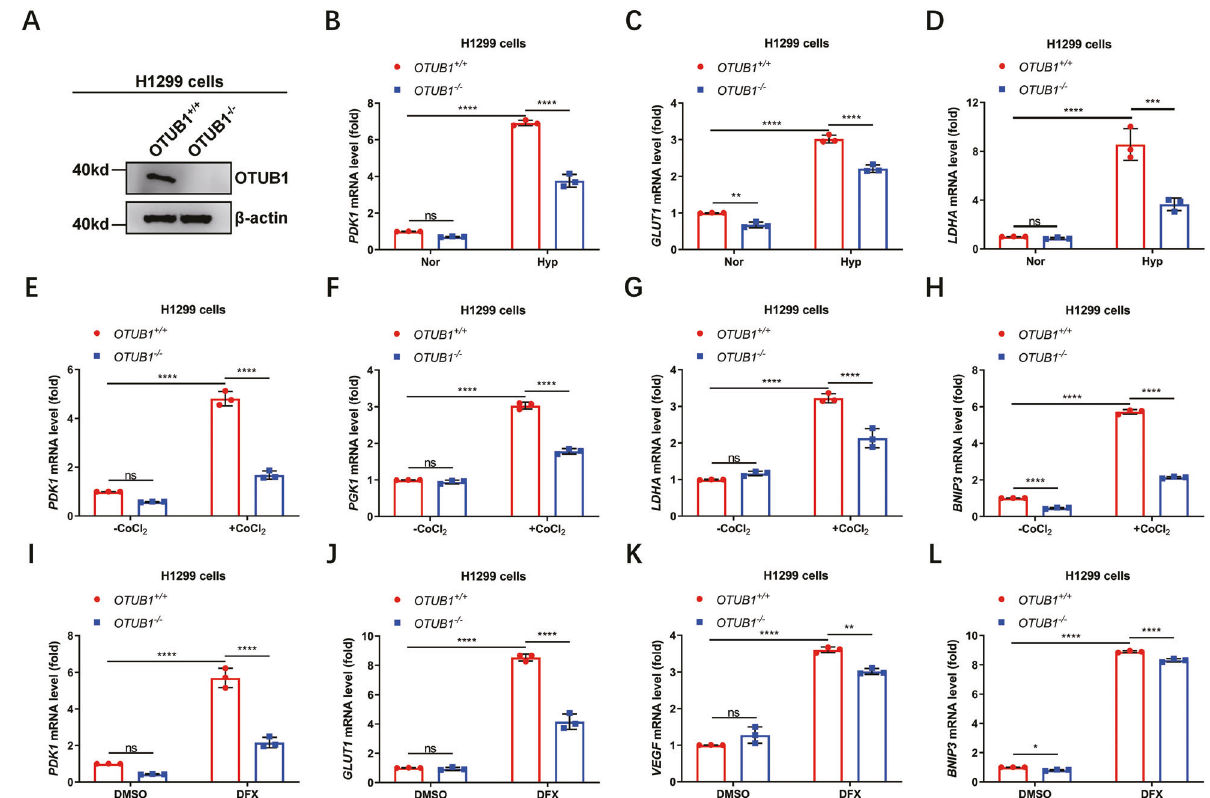
Fig. 2 Loss of OTUB1 diminishes hypoxia signaling. A Western blot analysis of indicated proteins in OTUB1 -de fi cient or wildtype H1299 cells ( OTUB1 − / − or OTUB1 + / + ). B – D qPCR analysis of PDK1 ( B ), GLUT1 ( C ), and LDHA ( D ) mRNA in OTUB1 -de fi cient or wildtype H1299 cells ( OTUB1 − / − or OTUB1 + / + ) cultured under normoxia (21% O 2 ) or hypoxia (1% O 2 ) for 24 h. Two-way ANOVA analysis; Data show mean ± SD; Tukey ’ s multiple comparisons test; ns, not signi fi cant, *Adjusted p < 0.05, **Adjusted p < 0.01, ***Adjusted p < 0.001, ****Adjusted p < 0.0001; Data from 3 independent experiments. E – H qPCR analysis of PDK1 ( E ), PGK1 ( F ), LDHA ( G ) and BNIP3 ( H ) mRNA in OTUB1 -de fi cient or wildtype H1299 cells ( OTUB1 − / − or OTUB1 + / + ) treated with or without CoCl 2 (200 μ M) for 8 h. Two-way ANOVA analysis; Data show mean ± SD; Tukey ’ s multiple comparisons test; ns, not signi fi cant, *Adjusted p < 0.05, **Adjusted p < 0.01, ***Adjusted p < 0.001, ****Adjusted p < 0.0001; Data from 3 independent experiments. I – L qPCR analysis of PDK1 ( I ), GLUT1 ( J ), VEGF ( K ), and BNIP3 ( L ) mRNA in OTUB1 -de fi cient or wildtype H1299 cells ( OTUB1 − / − or OTUB1 + / + ) treated with DMSO or DFX (150 μ M) for 8 h. Two-way ANOVA analysis; Data show mean ± SD; Tukey ’ s multiple comparisons test; ns, not signi fi cant, *Adjusted p < 0.05, **Adjusted p < 0.01, ***Adjusted p < 0.001, ****Adjusted p < 0.0001; Data from 3 independent